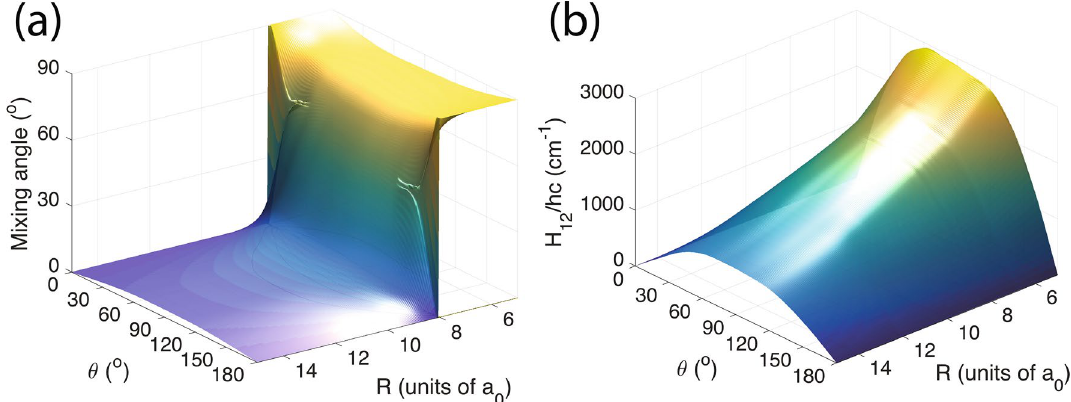
Figure 3. Mixing angle β( R , r , θ) (panel a ) and coupling potential H 12 ( R , r , θ) (panel b ) between the diabatic 1.832 a 0 as functions of Jacobi coordinates R and θ 1 2 A 4 2 A ′ and ′ states at r =